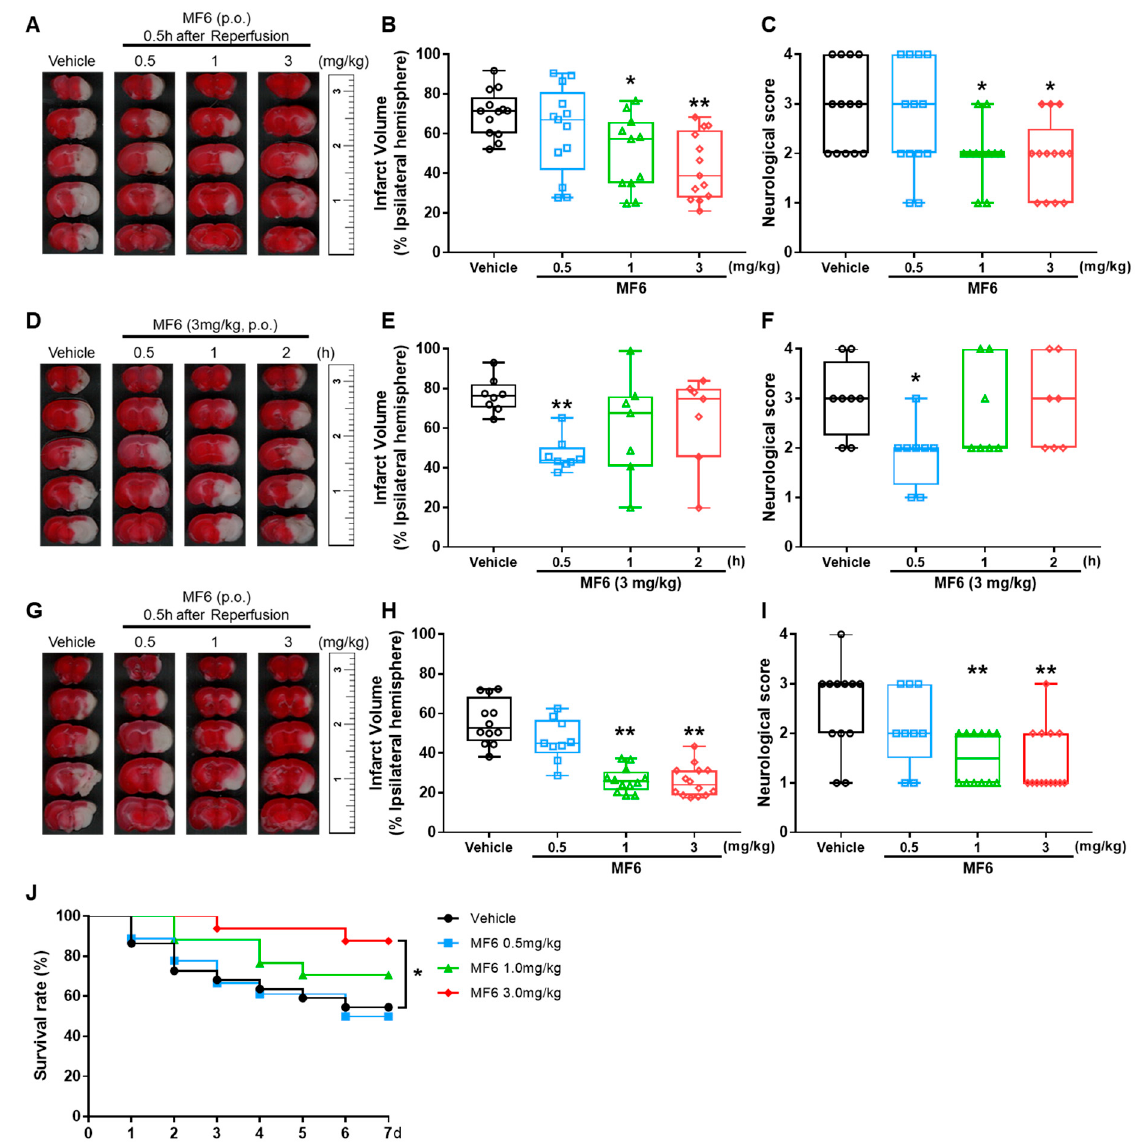
Figure 3. Effects of MF6 post-treatment on I/R injury in mice. Mice were subjected to tMCAO for 2 h. ( A – C ) MF6 was administrated at different concentrations (0.5, 1 or 3 mg/kg) 30 min after reperfusion. Representative images of TTC staining ( A ), quantitative analysis of the infarct volumes ( B ) and neurological deficits ( C ) at 24 h after reperfusion (n = 11–13). ( D – F ) MF6 (3 mg/kg) was administrated at 0.5, 1 or 2 h after reperfusion. Representative images of TTC staining ( D ), quantitative analysis of infarct volumes ( E ) and neurological deficits ( F ) at 24 h after reperfusion (n = 7–8). ( G – J ) MF6 was administrated with different concentrations (0.5, 1, 3 mg/kg) 30 min after reperfusion. Representative images of TTC staining ( G ), quantitative analysis of infarct volume ( H ) and neurological deficits ( I ) at day 7 after reperfusion. The number of living animals in each group every day was recorded, and survival rate ( J ) was calculated (n = 9–14). * p < 0.05, ** p < 0.01 vs. the I/R-treated group with the CMC group (vehicle). Differences were statistically analyzed using one-way analysis of variance (ANOVA) followed by Dunnett’s test.